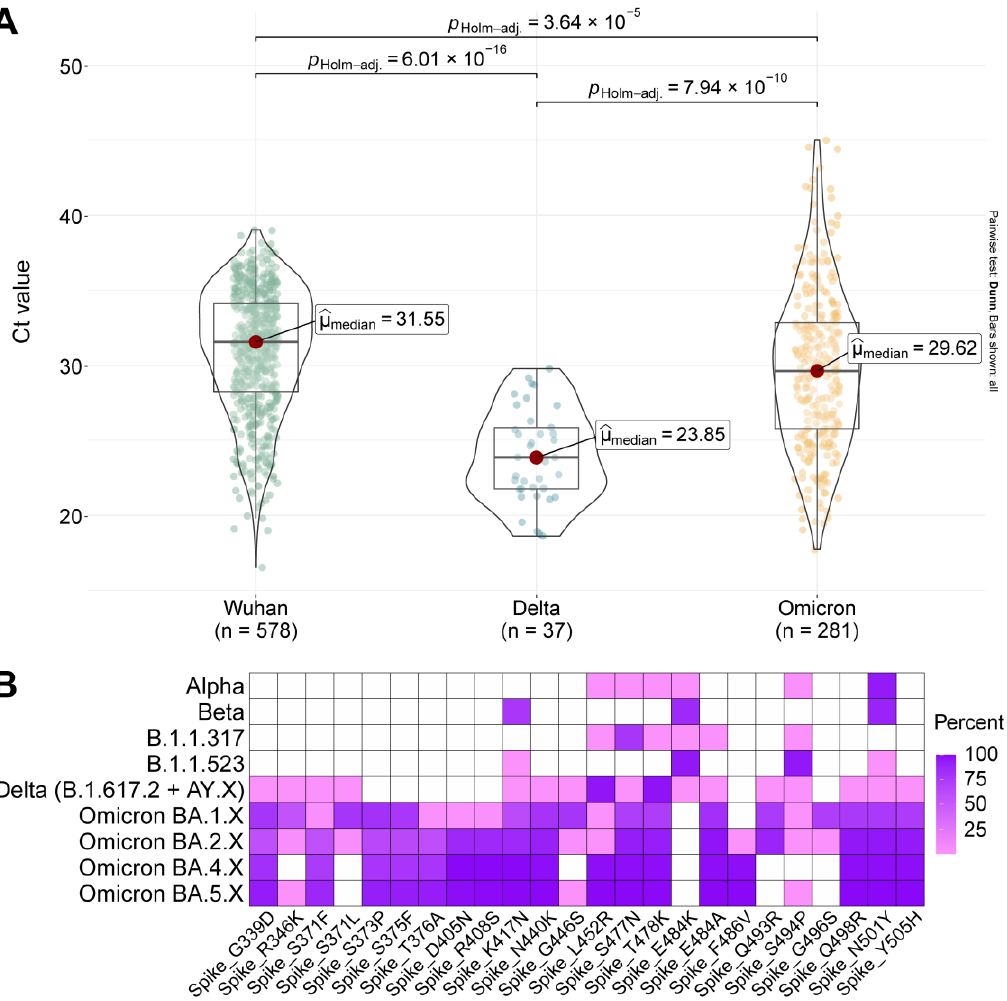
Figure 5. Viral load and mutation composition in the S protein of major SARS-CoV-2 genetic lineages. ( A ) PCR threshold cycle in nasopharyngeal swab compositions in primary patients during Wuhan-, Delta-, and Omicron-dominant periods. The differences between Delta and Wuhan ( p < 0.0001) and Delta and Omicron ( p < 0.0001) were statistically significant. ( B ) Composition of mutations within the RBD of the main genetic variants during Alpha-, Beta-, Delta-, Omicron-dominant periods and endemic variants SARS-CoV-2 in Moscow. The presence of amino acid substitutions are given relative to the Wuhan reference strain.